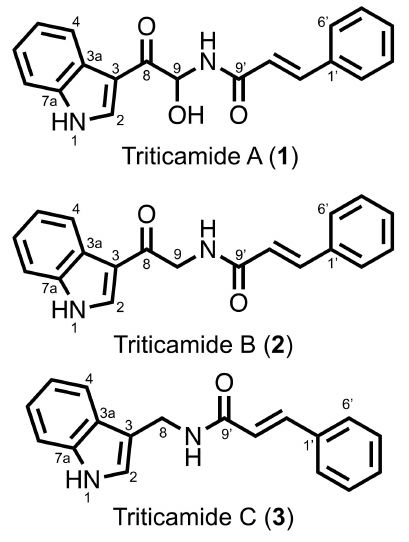
Figure 2. Chemical structures of 1 – 3 .